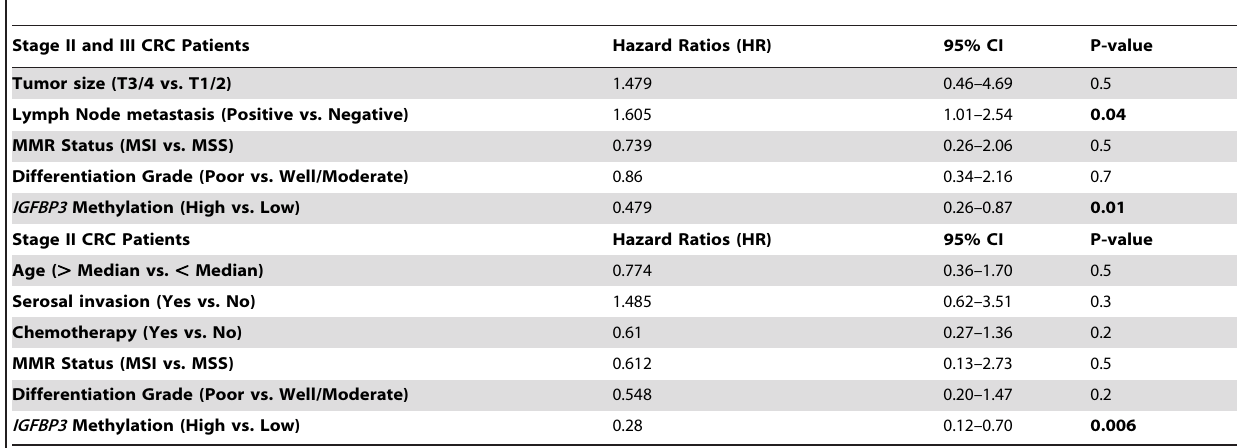
Table 3. Multivariate analysis of disease-free survival based on IGFBP3 promoter methylation in stage II and III CRC patients.